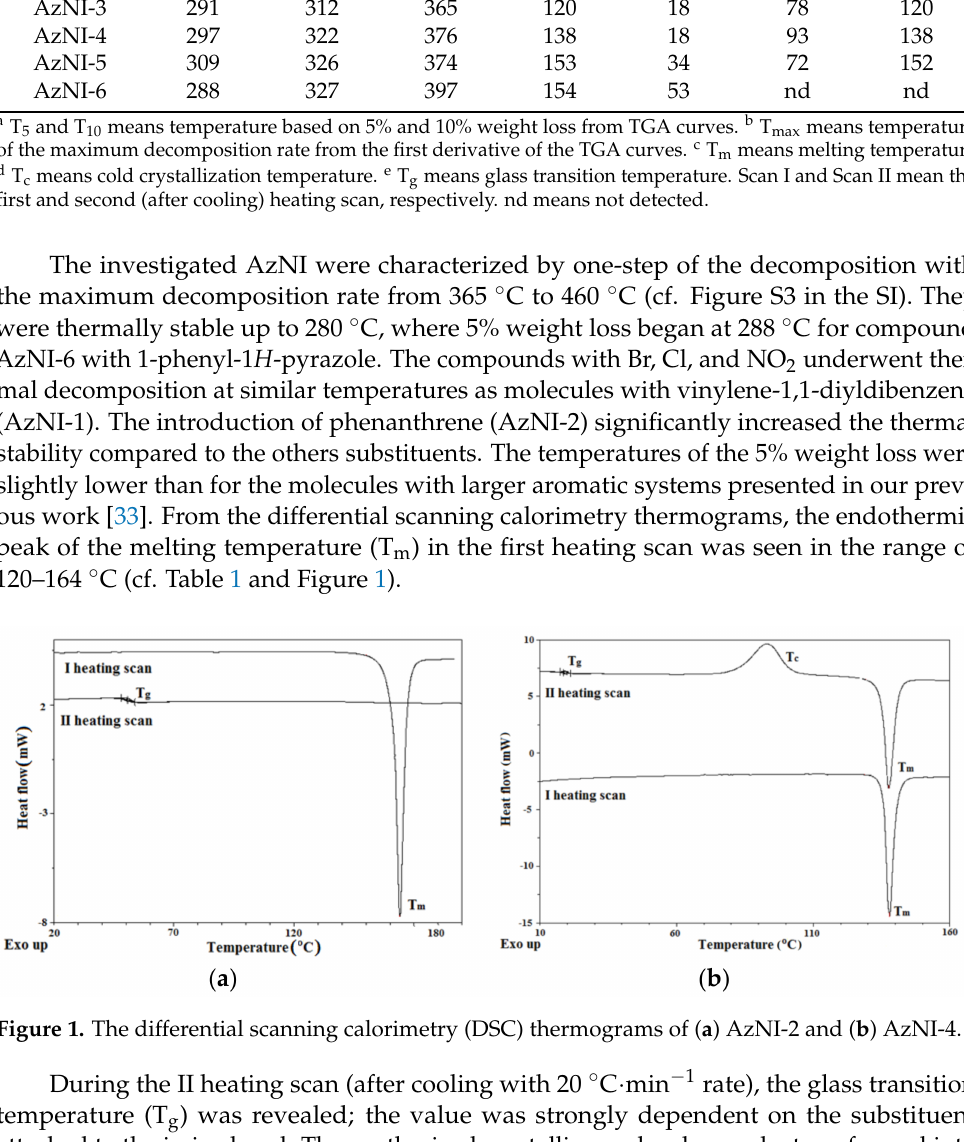
a T 5 and T 10 means temperature based on 5% and 10% weight loss from TGA curves. of the maximum decomposition rate from the first derivative of the TGA curves. c T m means melting temperature